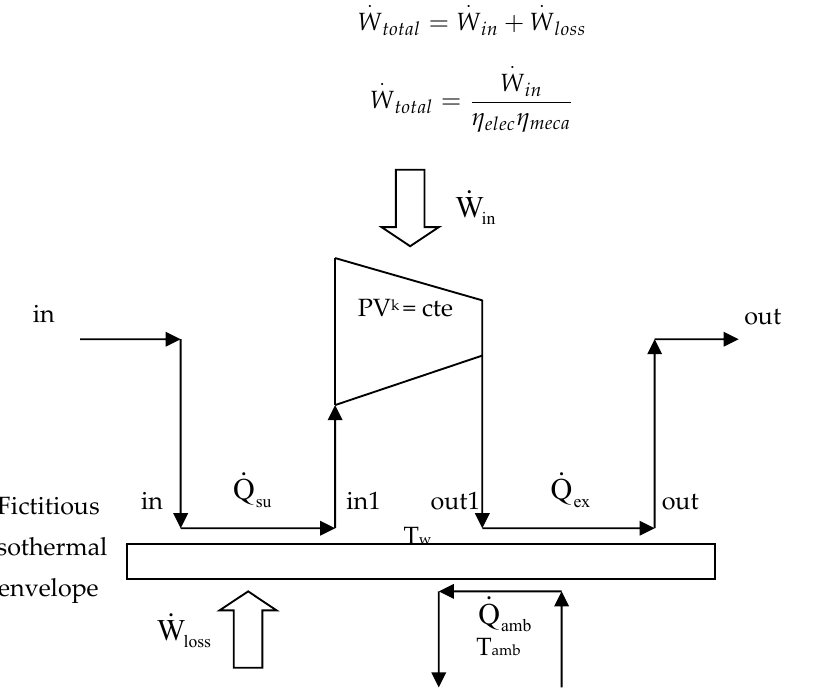
Figure 2. Scheme of the compressor modeling principles. Adapted with permission from Ref. [4]. 2014, Elsevier.